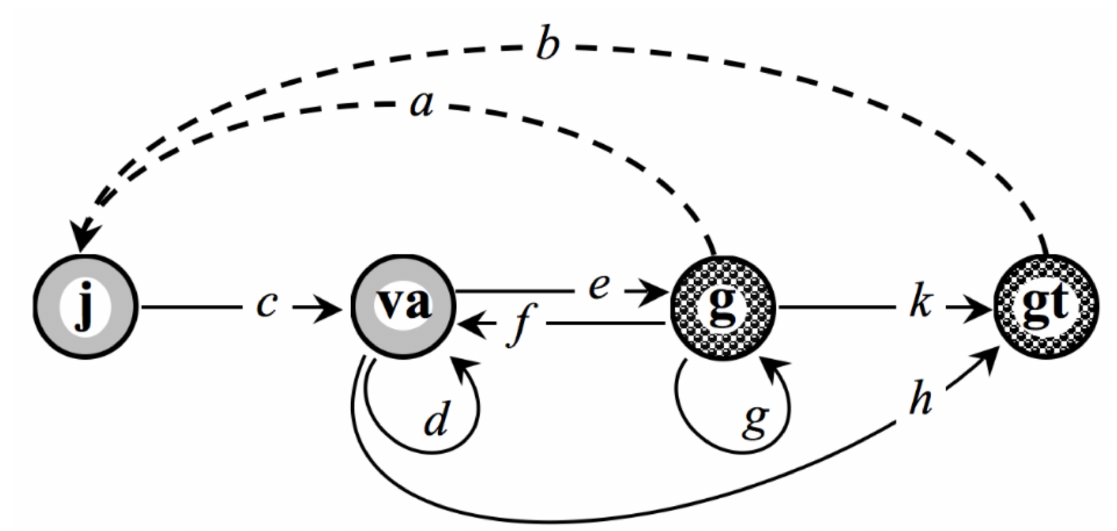
Figure 1. Life cycle graph for a local population of Eritrichium caucasicum observed once a year. Ontogenetic stage notations: j , juvenile plants; va , virginal plants and the adult non-flowering ones, g , generative plants; gt , terminally generative plants, the stages being distinguishable in the field. Solid arrows indicate transitions occurring for one year (no transition, in particular); dashed arrows correspond to the annual recruitment